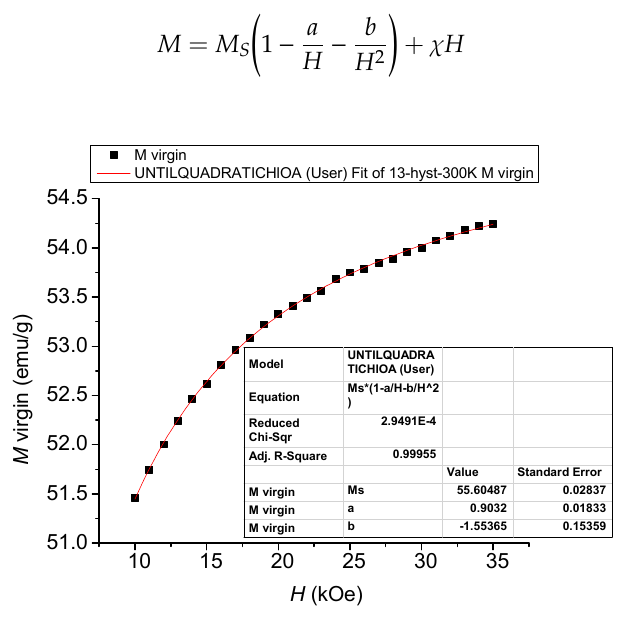
Figure 7. Representative fitted curve for M at 300 K calculated by the law of approach to saturation.